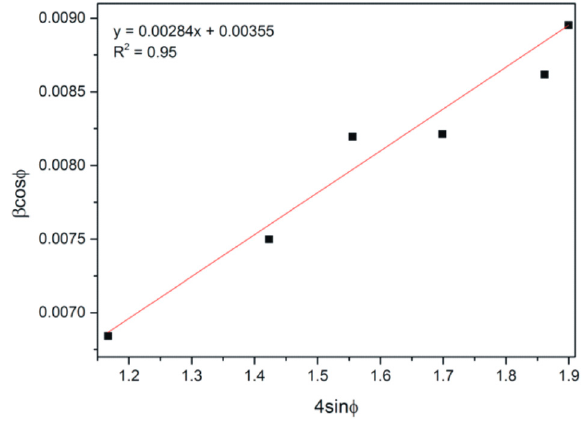
Figure 7. The W-H analysis of CaCO 3 precipitated with lysozyme (0.1%) after 10 min.